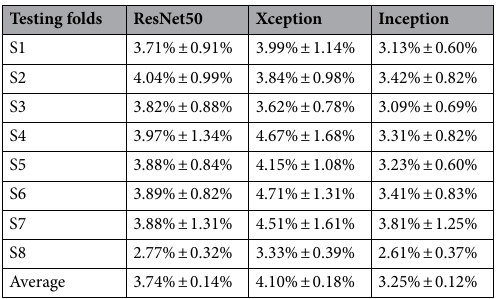
needle puncture sequence, we divided the overall classification into four sequential binary classifications: Fat vs Interspinous Ligament; Interspinous Ligament vs Ligamentum Flavum; Ligamentum Flavum vs Epidural Space, and Epidural Space vs Spinal Cord. The overall prediction accuracies of all four classifications reached to more than 90%. ResNet50 presented the best overall performance compared to Xception and Inception. Due to the unique features of epidural space in OCT images, it was possible to achieve > 99% precision when the needle arrived the epidural space. Table 2 showed the accuracies of ~ 99.8% and 100% when classifying Epidural Space vs Ligamentum Flavum and Epidural Space vs Spinal Cord. This will allow accurate detection of the epidural space for injection of the anesthetic during epidural anesthesia. The sequential transition from one binary classifier to the next was controlled accurately using a simple logic, which was demonstrated in a video simulating the insertion of a needle through the five tissue layers (Fig. 2). In the future, this can be improved by combining CNN with Recurrent Neural Network (RNN) to handle the temporal dimension of video streaming data 61 . Additionally, we developed a CNN regression model to estimate the needle distance to the dura mater upon entry of the epidural space. For the regression task, Inception provided better performance compared to Xception and ResNet50. The mean relative error was 3.05%, which was able to track the accurate location of the